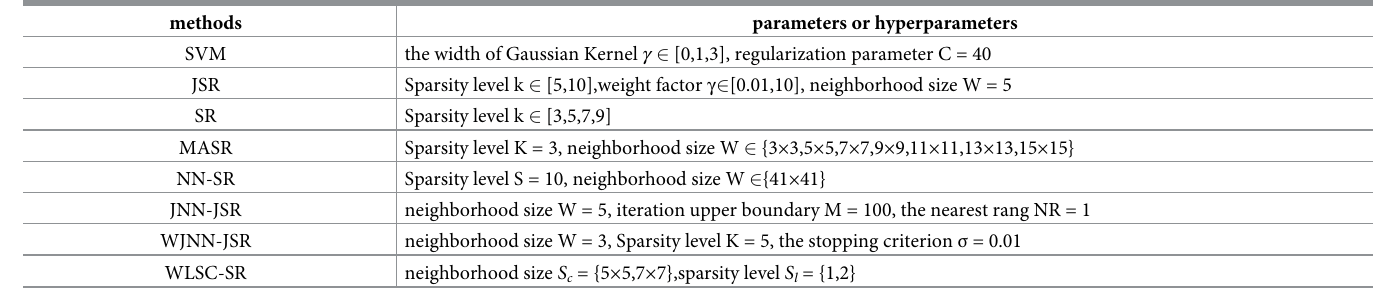
Table 5. The ideal parameters or hyperparameters used by the various algorithms. methods parameters or